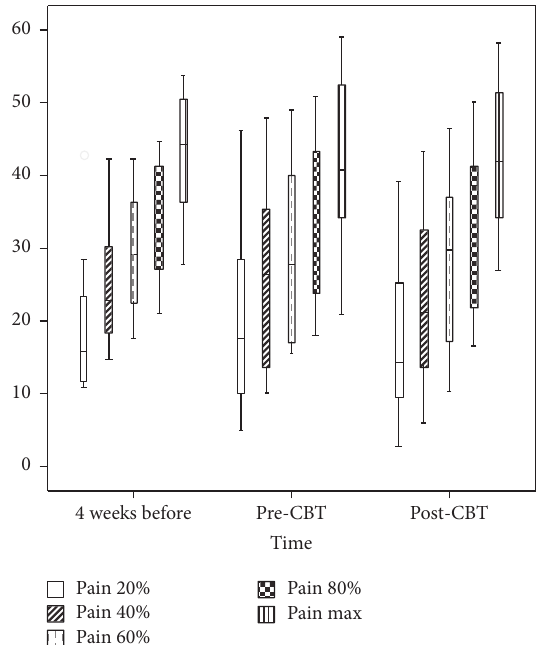
Figure 2: The actual pressure (mmHg) to the rectum at 20, 40, 60, 80, and 100% of the maximal tolerable rectal pain according to ratings made by subjects with IBS four weeks before CBT, before, and after CBT. The pressure was induced by a barostat